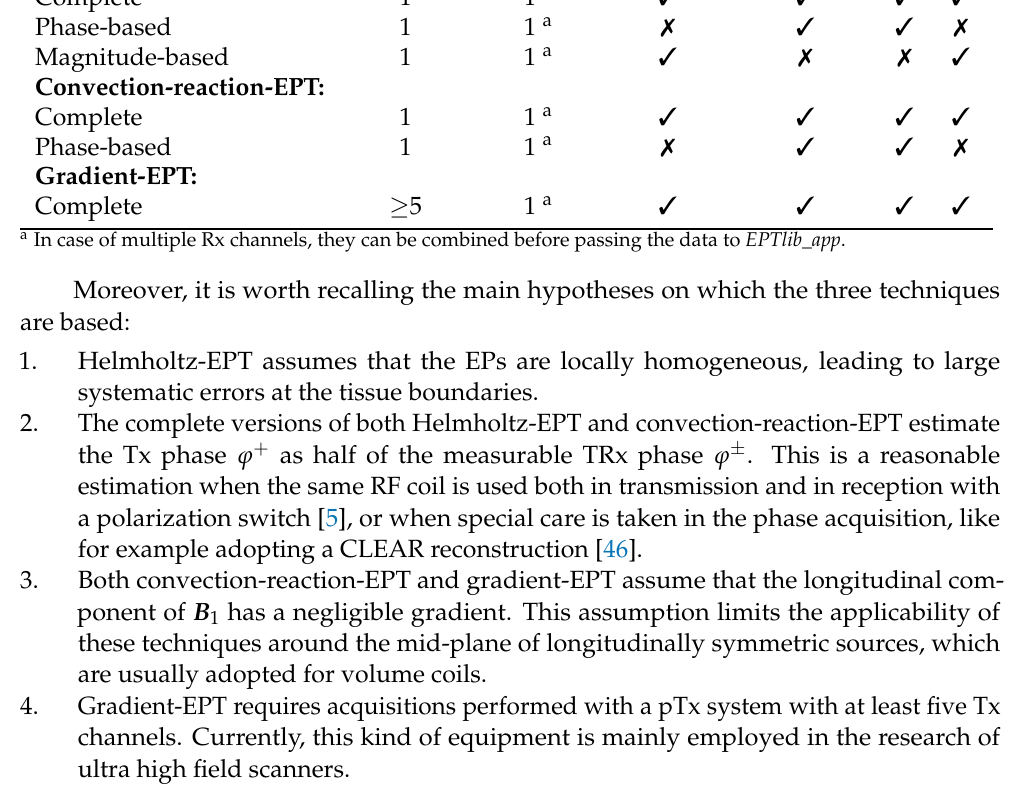
Table 1. Summary of the input requirements and output capabilities of the EPT techniques implemented in EPTlib . Input Output Tx Chan. Rx Chan. Tx Sens. TRx Phase ε